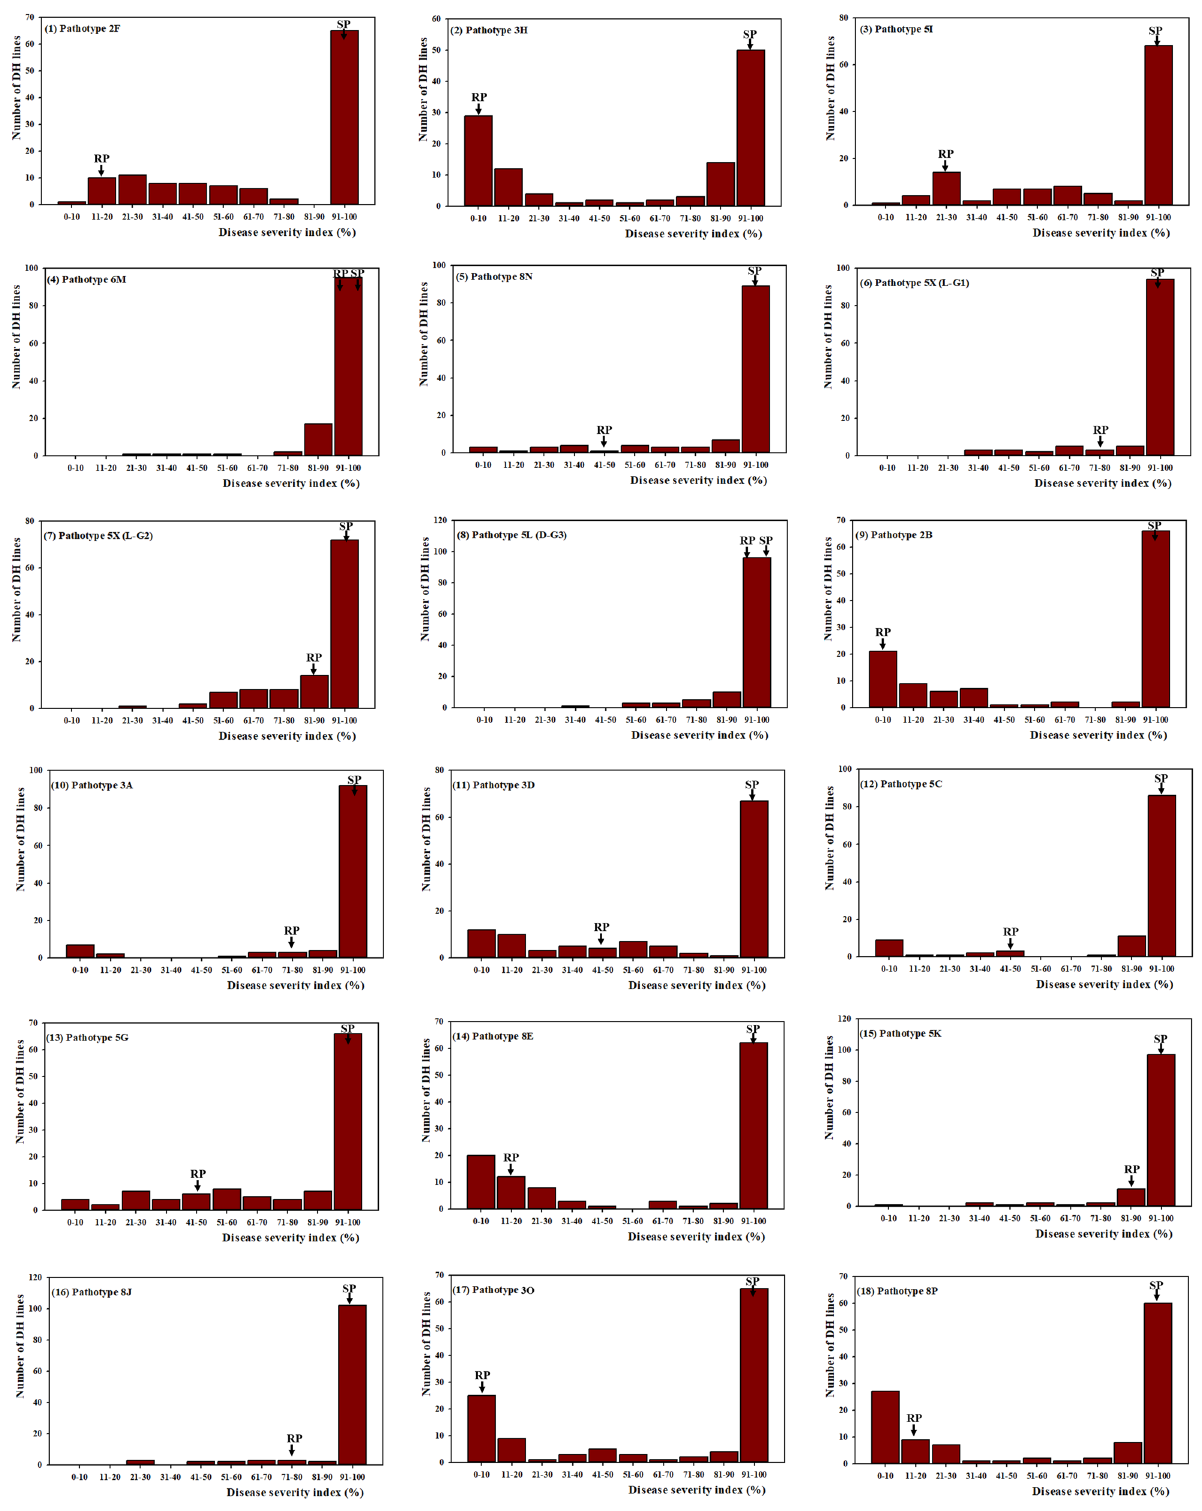
Figure 1. Frequency distribution of doubled haploid lines derived from the Brassica napus cv. ‘Tosca’ for resistance to Plasmodiophora brassicae single-spore isolates (SSIs) representing pathotypes 2F (1), 3H (2), 5I (3), 6M (4) and 8N (5), and field isolates representing pathotypes 5X (L-G1(6) and L-G2(7)), 5L (8), 2B (9), 3A (10), 3D (11), 5C (12), 5G (13), 8E (14), 5K (15), 8J (16), 3O (17) and 8P (18). The SSIs and field isolates were identified prior to and after the introduction of clubroot-resistant canola cultivars in Canada,